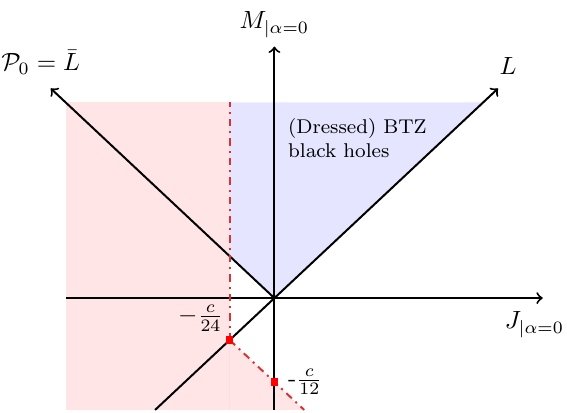
Figure 6. The bound (4.18) restricts the parameters L and (cid:22) L of the bulk theory to lie outside the red region (left of the dash-dotted line). When B ( x + ) = 0, eq. (4.18) puts a lower bound on the angular momentum of BTZ black holes, i.e. J